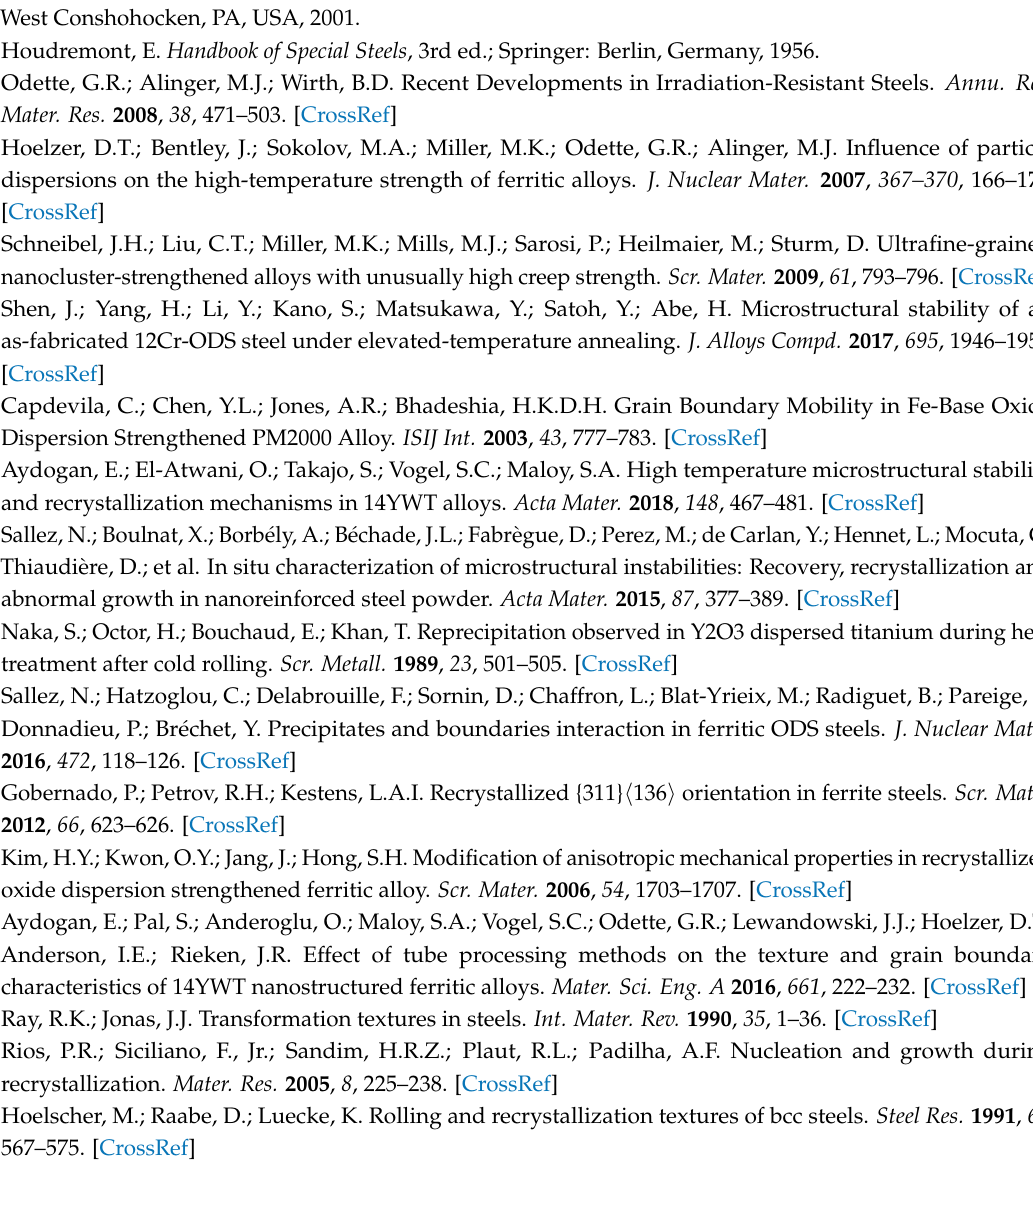
Figure S1: (a) Orientation (b) gray scale and (c) kernel average misorientation maps of FeCrAl alloy annealed at 1000 ◦ C for 2 h.; Figure S2: The gray scale, orientation and KAM maps of 14YWT alloys after (a) 0.5 h (b) 1 h (c) 2 h (d) 3 h and (e) 4 h of annealing at 1100 ◦ C. Scales of all the micrographs are the